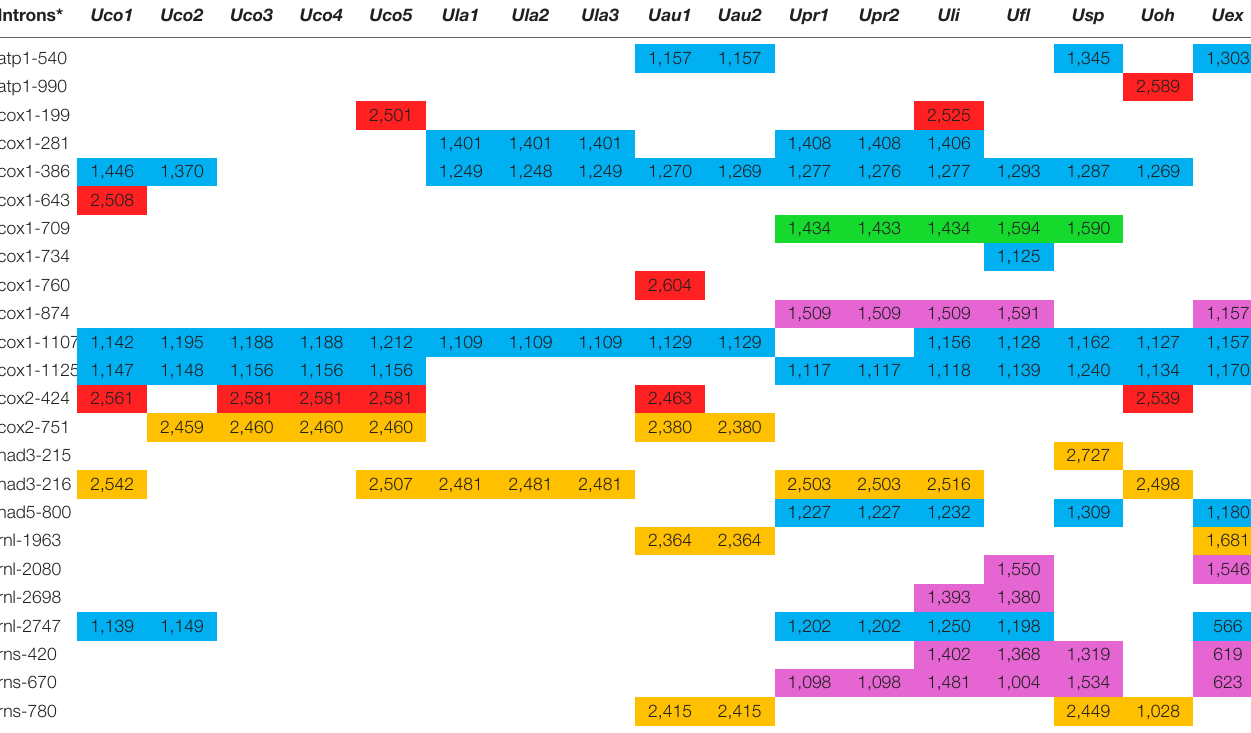
TABLE 3 | Comparison of insertion site, size and group of introns in the 17 Ulva mitogenomes. Introns*